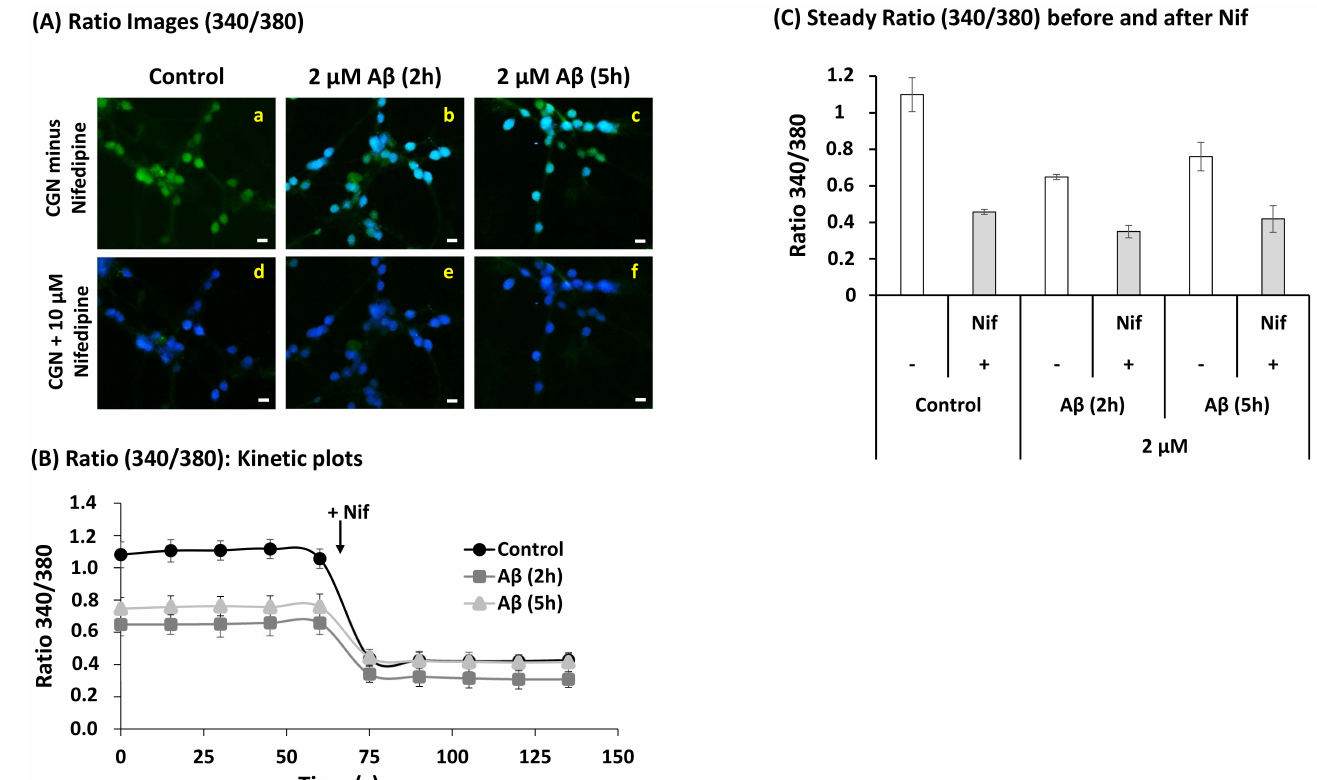
Figure 7. Intracellular cytosolic calcium concentration decreases in the neuronal soma after A β (1–42) treatment. Mature CGN were pre-incubated with 2 µ M A β (1–42) for 2 h or 5 h at 37 ◦ C and 5% CO 2 and loaded with 5 µ M Fura-2 for 60 min, as previously described in Section 2. Nifedipine (10 µ M), a calcium channel blocker, was used as positive control to confirm the effect of the total blockade of LTCCs. ( A ) Representative ratio (340/380) images of Fura-2-loaded CGN of untreated (a) and treated cells with 2 µ M A β (1–42) for 2 h (b) or 5 h (c) and after the addition of nifedipine in the control group (d) and in cells treated with 2 µ M A β (1–42) for 2 h (e) or 5 h (f). Scale bar inserted in fluorescence microscopy images = 10 µ m. ( B ) Kinetic plots of the average ± s.e. fluorescence ratio (340/380) before and after the addition 10 µ M nifedipine (+Nif) at the time indicated by the arrow. ( C ) The analysis of fluorescence intensity data for GCN loaded with Fura-2 showed a statistically significant decrease ( ≈ 50%) in the steady ratio (340/380) after A β (1–42) treatment (2 h and 5 h) with respect to the control (untreated cells), p < 0.05. The addition of nifedipine totally blocks the entry of Ca 2+ in the soma in untreated and treated cells as demonstrated by the decrease in the ratio showing that A β partially attenuates LTCC function. The ratio (340/380) values shown are the average ± s.e. of experiments done in triplicate with at least two different preparations of CGN ( n > 400 neuronal soma of fields taken from at least six plates for each